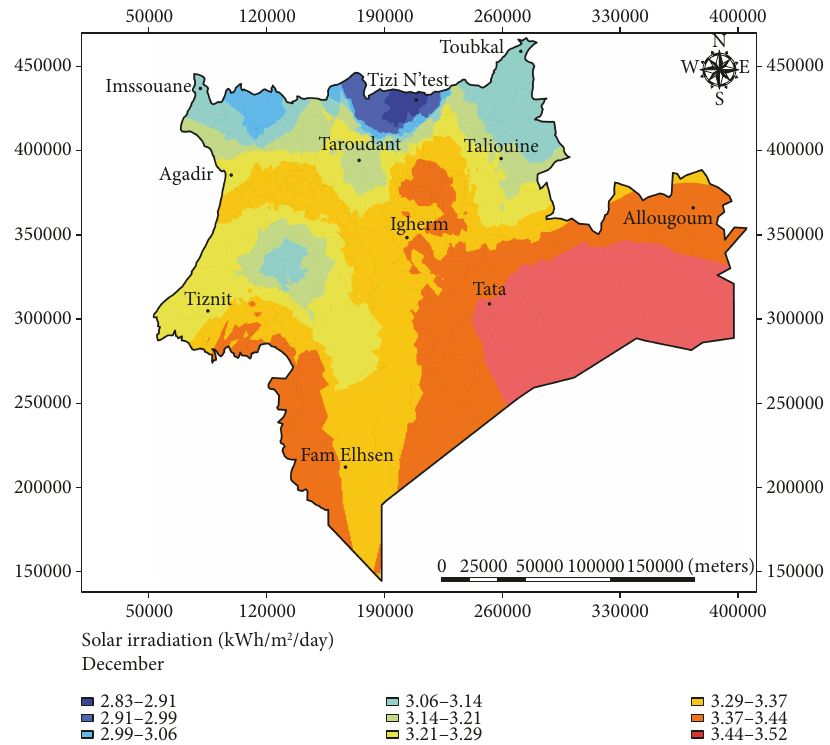
Figure 8: Solar energy potential map of the Souss-Massa area for the month of December as estimated by the ANN and designed with the Kriging interpolation